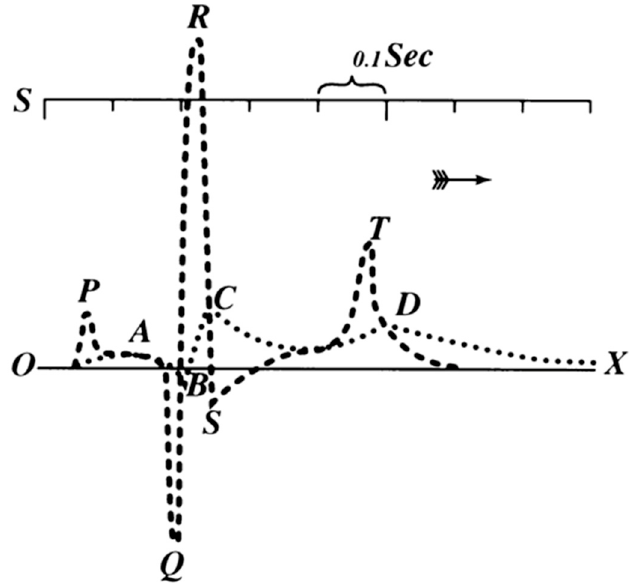
Figure 2. Einthoven superimposed two electrocardiographs (ECGs), in order to highlight the differences in the two tracks. The one labelled with ABCD was obtained with the string galvanometer while the one labelled with PQRST was obtained by Einthoven with the application of a mathematical correction.